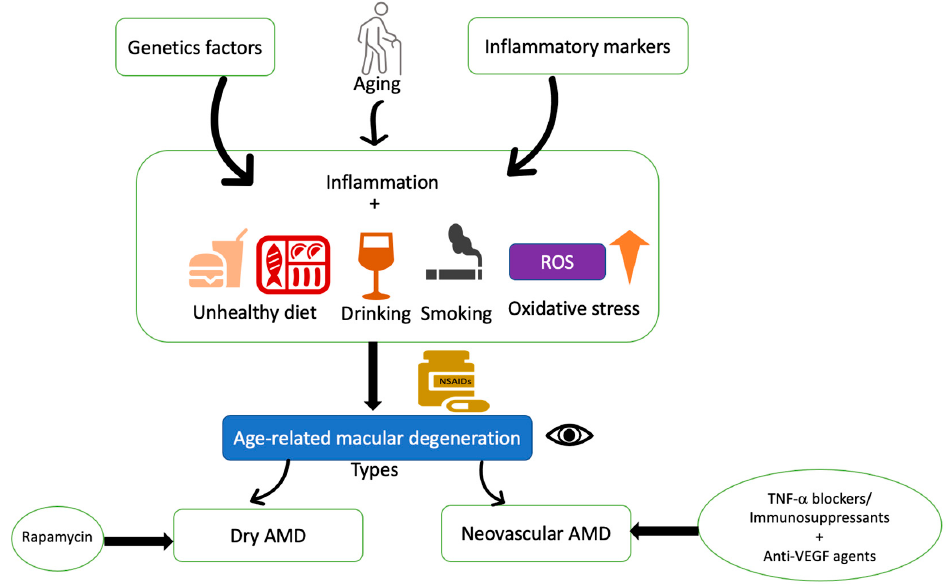
Figure 4. Schematic diagram of therapeutic rationale for non-vascular and neovascular AMD. Age-related macular degeneration is a complex disease affected by various factors, such as genetic factors, aging, inflammatory effects, and oxidative stress. Several risk factors such as unhealthy diet, smoking, alcohol consumption, and obesity are related to oxidative stress. Topical or intravitreal use of non-steroidal anti-inflammatory drugs has shown a preventive effect on AMD. Anti-inflammatory agents/immunosuppressants along with anti-VEGF therapies are currently in use for neovascular AMD treatment. Rapamycin is in clinical trials for Dry